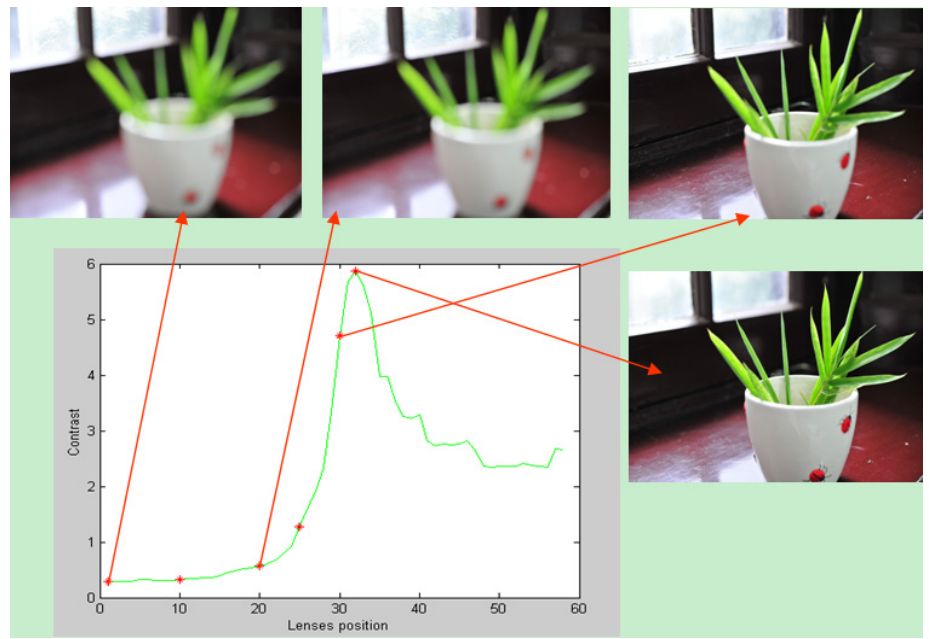
Figure 2. Image contrasts at different lens